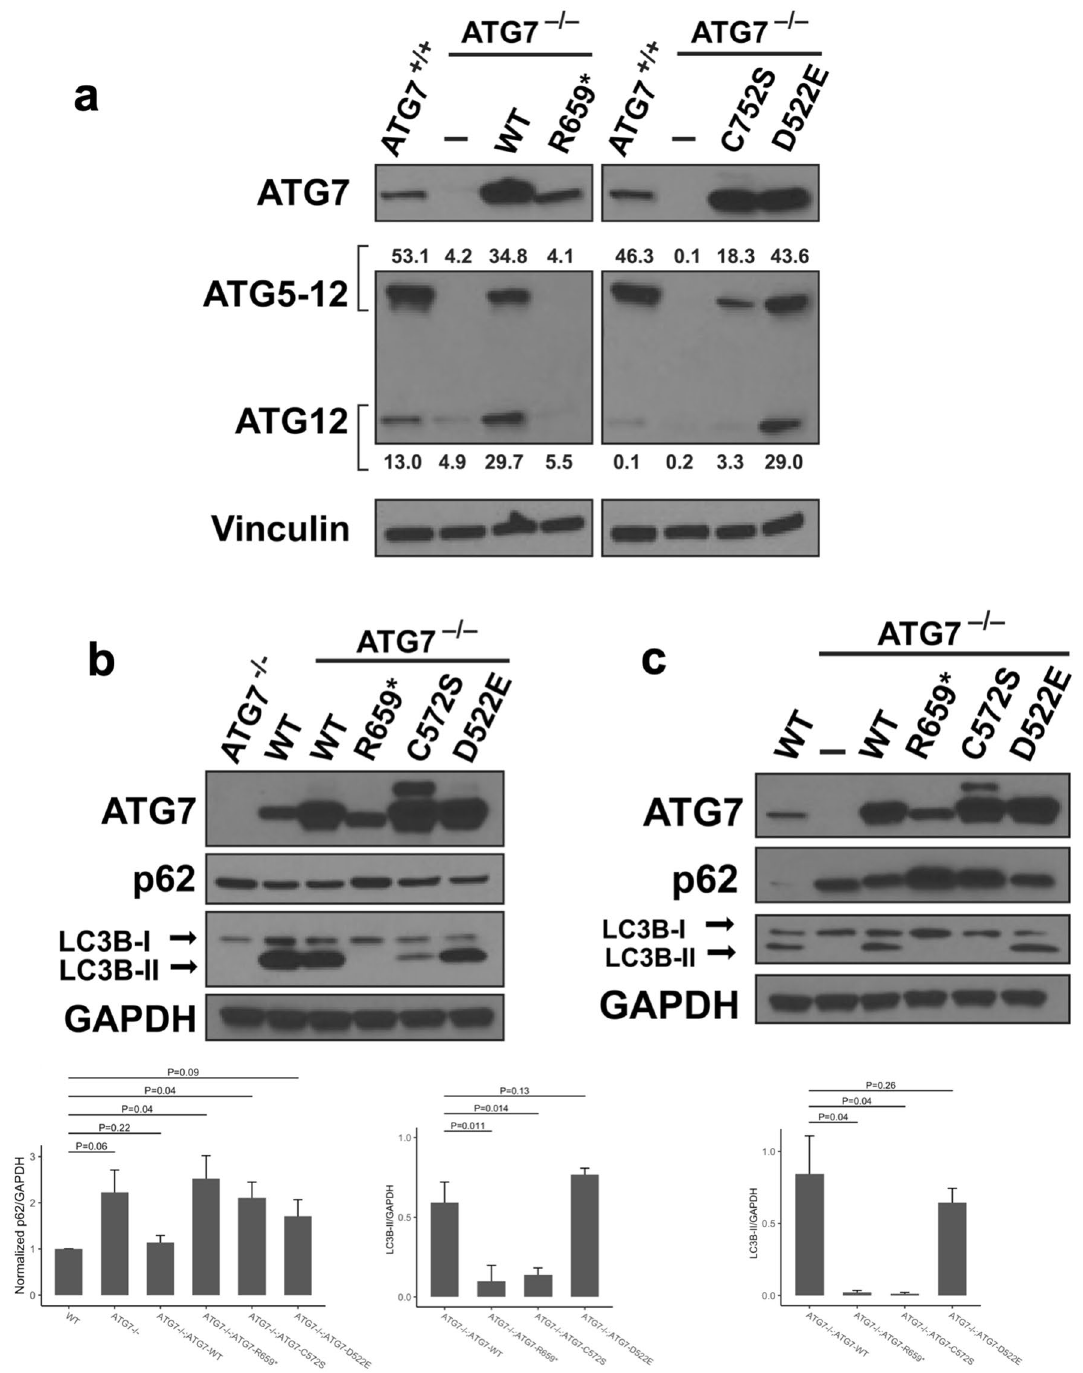
Figure 5. Impaired ATG5-12 complex formation and elevated p62 levels in cholangiocytes expressing ATG7 R659*. ( a ) Cholangiocytes expressing ATG7 R659* unable to form ATG5-12 complex. The ATG7 R659* and C572S variants fail to rescue the ATG5-12 complex formation defect observed in MMNK-1 ATG7 -/- cholangiocytes. Protein lysates were obtained from cell lines under basal conditions. Free ATG12 and the ATG5-12 complex can be detected at 15 kDa and 55 kDa, respectively, on the western blot. ( b ) Top: Elevated p62 expression due to autophagy defects in cholangiocytes expressing ATG7 mutants. Cholangiocytes expressing ATG7 WT, R659*, D522E, and C572S were cultured using normal growth media. Expression of ATG7, p62, LC3B, and GAPDH were detected on the western blot. Bottom left: Bar plot with y-axis showing normalized p62/GAPDH ratio and x-axis showing the distinct cell line genotypes. Normalized refers to the normalization of all genotypes in relation to the wild-type cell line. P-values are shown for statistical t-test comparisons. Bottom right: Bar plot with y-axis showing LC3B-II/GAPDH ratio and x-axis showing the distinct cell line genotypes. ( c ) Top: Cholangiocytes expressing ATG7 WT, R659*, D522E, and C572S starved with HBSS for 3 h. Expression of ATG7, p62, LC3B, and GAPDH were detected on the western blot. Bottom: Bar plot with y-axis showing LC3B-II/GAPDH ratio and x-axis showing the distinct cell line genotypes. Original blots are presented in Supplementary Fig. S9 online. Quantifications reflect the mean of triplicates experiments for conditions and genotypes. P values are provided from t-tests